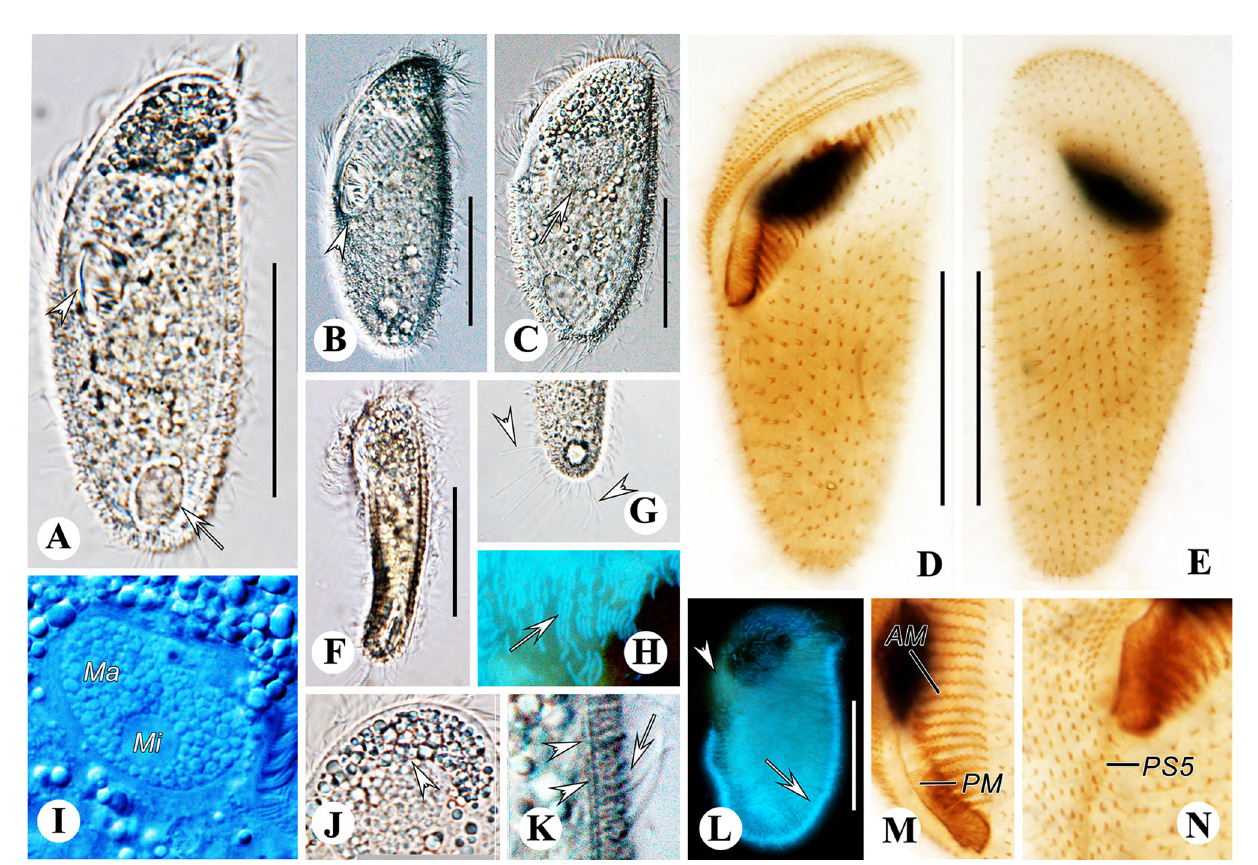
FIGURE 7 | Metopus parapellitus sp. n. from life with bright- fi eld (A, F, G, J) , differential interference (B, C, I, K) illuminations and UV light (H, L) , and after protargol staining (D, E, M, N) . (A) Ventral view showing body shape, paroral membrane (arrowhead), and contractile vacuole (arrow). (B) Ventral view showing body shape and the proximal end of the adoral zone (arrowhead). (C) Dorsal view showing body shape and macronucleus (arrow). (D, E) Ventral (D) and dorsal (E) view of the holotype, showing ciliature and macronucleus. (F) Left view showing body dorsoventrally fl attened body. (G) Ventral view showing caudal cilia (arrowheads). (H, L) Auto fl uorescence of ectosymbionts (arrows) and zone lacking ectosymbionts (arrowhead). (I) Micronucleus and macronucleus. (J) Cytoplasmic granule aggregation at the anterior pole of the cell (arrowhead). (K) Lateral view of ectosymbionts (arrow) and the layer of mucus (arrowheads). (M) Adoral membranelles and paroral membrane. (N) Right lateral view showing the distal end of perizonal stripe row 5. AM, adoral membranelles; Ma, macronucleus; Mi, micronucleus; PM, paroral membrane. Scale bars: 35 m